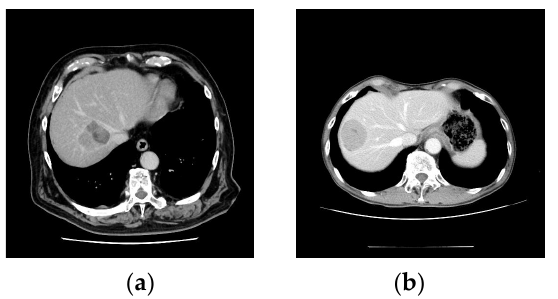
Figure 1. ( a ) A lesion with proximity to major vessels. ( b ) A lesion with no proximity to major ves- sels.